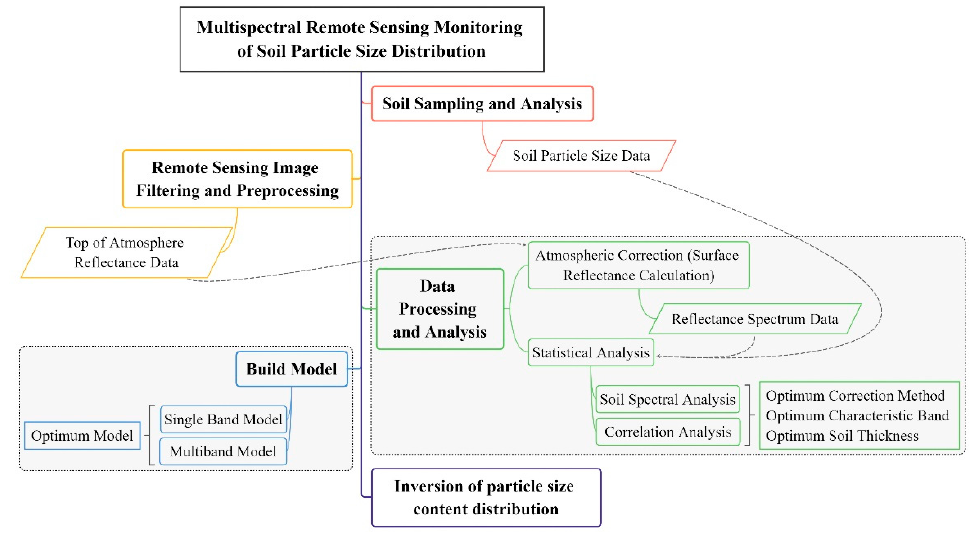
Figure 1. Experimental flow chart.